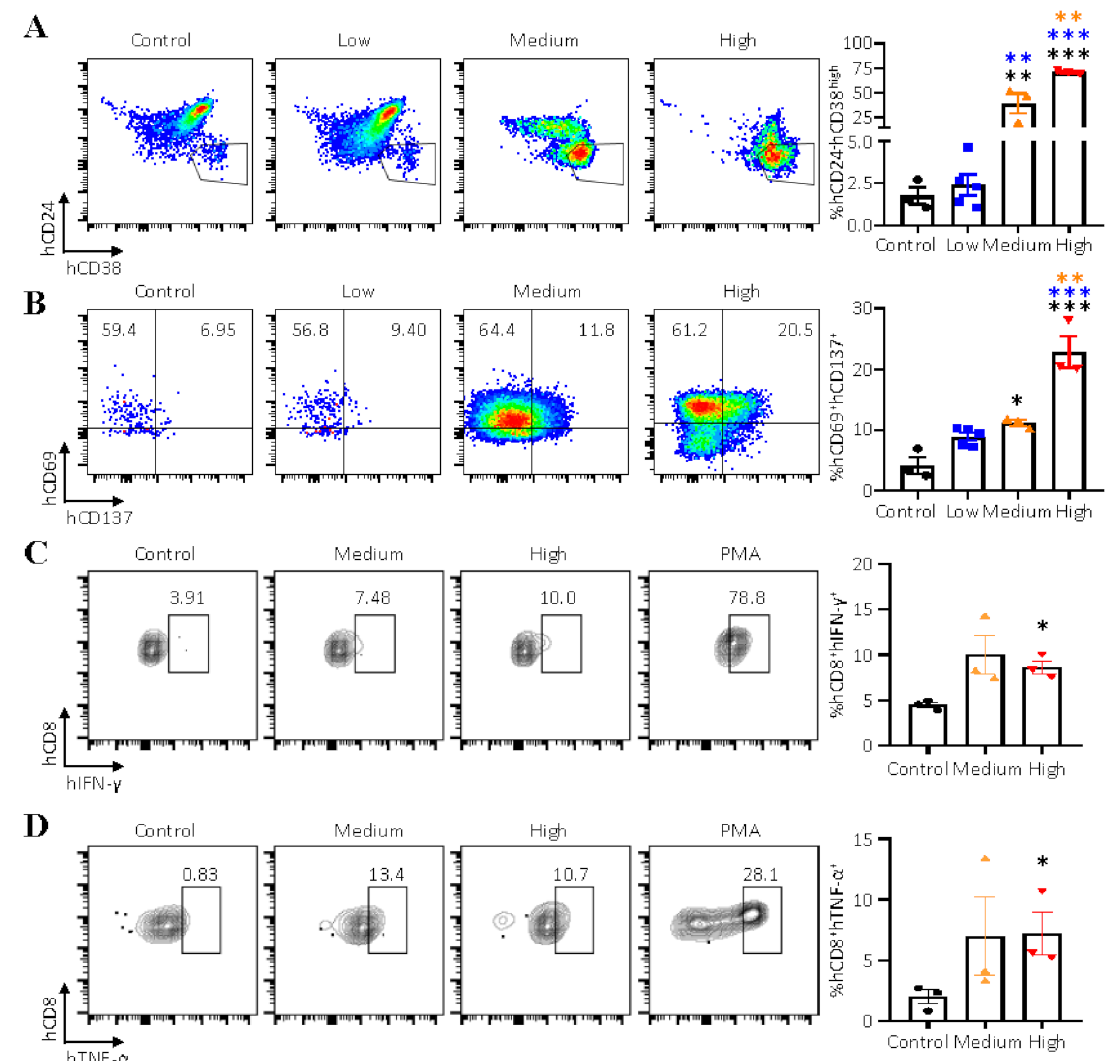
Figure 5. ( A ) ( left ) Representative flow plot showing hCD24 - hCD38 high B cell subsets in splenocytes based upon staining with hCD38 and hCD24 (pre-gated on the mCD45 - hCD45 + hCD19 + human cell population). ( right ) The frequencies of hCD24 - hCD38 high B cell subsets. ( B ) ( left ) Representative flow plot showing hCD69 + hCD137 + T cell subsets in splenocytes based upon staining with hCD69 and hCD137 (pre-gated on the mCD45 - hCD45 + hCD8 + human cell population). ( right ) The frequencies of hCD69 + hCD137 + T cell subsets. ( C ) ( left ) Representative flow cytometric analysis of the proportion of hIFN- γ + EBV-specific hCD8 + T cells after coculture with EBV-infected B cells. ( right ) The frequencies of hIFN- γ + hCD8 + T cells. ( D ) ( left ) Representative flow cytometric analysis of the proportion of hTNF- α + EBV-specific hCD8 + T cells after coculture with EBV-infected B cells. ( right ) The frequencies of hTNF- α + hCD8 + T cell subsets. Data points represent mean ± SEM of uninfected control mice ( n = 3), low ( n = 5), medium ( n = 3), high ( n = 3) doses (GRUs) of Akata-EBV-GFP infected mice, * p < 0.05, ** p < 0.01, *** p <